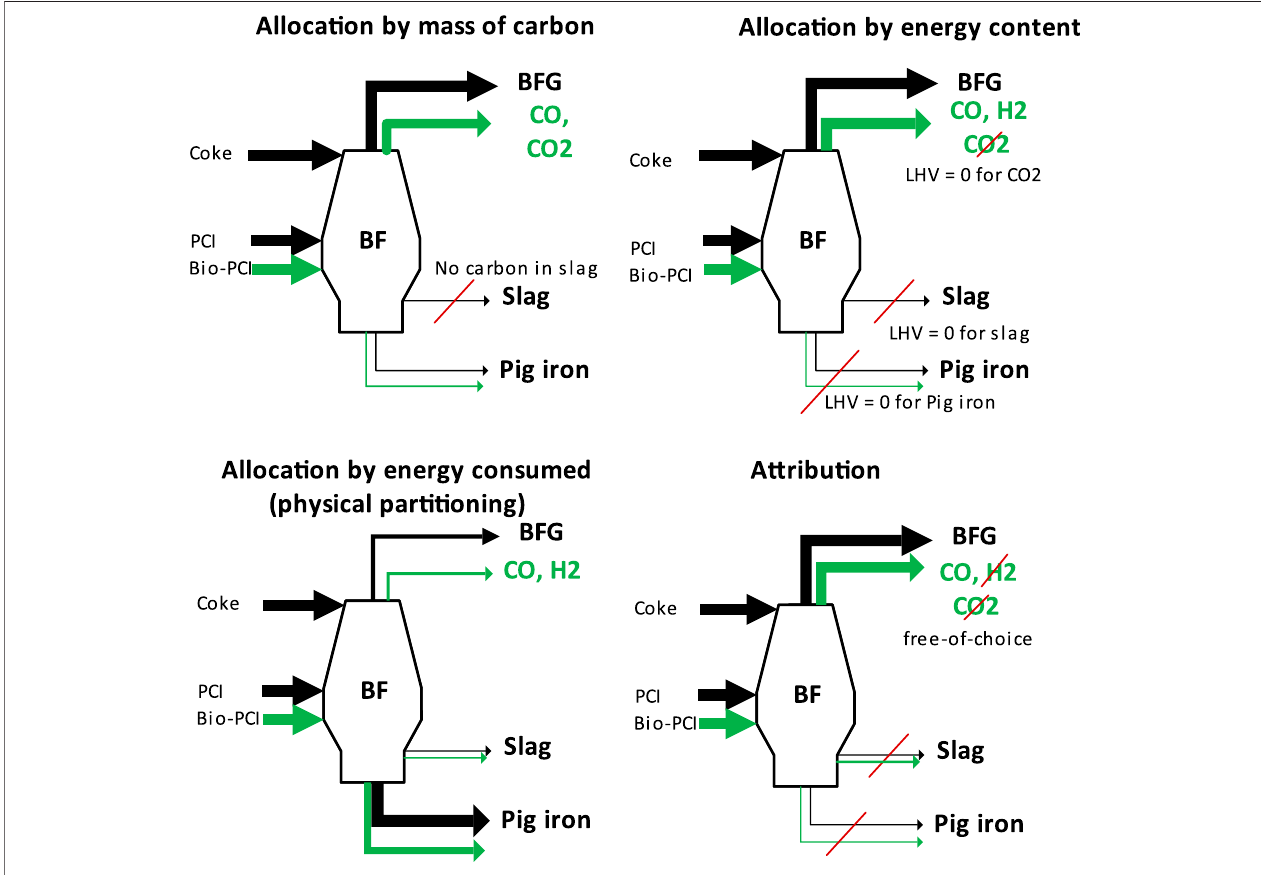
FIGURE 5 | Allocation of biogenic carbon/content to blast furnace ef fl uent streams. The biogenic share of each ef fl uent stream varies for each carbon allocation scheme. Carbon allocationby mass (top-leftpanel) ,by energy content (top-right panel) , and byphysical partitioning (bottom-leftpanel) versus free-choice carbon attribution (bottom-rightpanel) . Theattribution exampleisarbitrary andmay resemble thechoicetofavor energy-relatedproductsfrom BFG interms ofitsassociated production emissions. The black arrows indicate fossil carbon fl ows, and the green arrows indicate biogenic carbon fl ows.